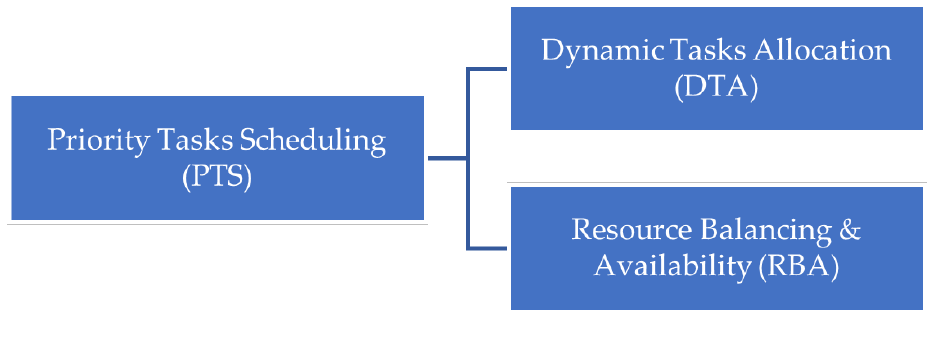
Figure 1. Scheduling